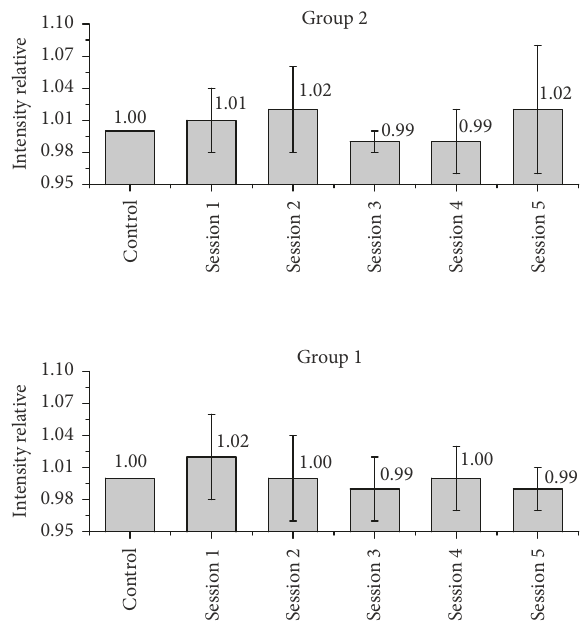
Figure 3: Relative intensity of phosphorus in the groups that were evaluated.